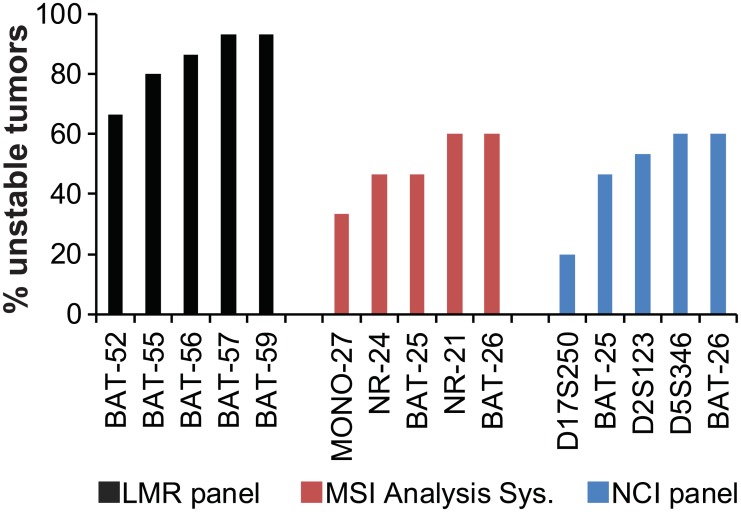
The relative MSI sensitivity of the LMR markers was significantly higher than that of currently used markers.A total of 15 tumors were classified as MSI-High using the LMR panel, the MSI Analysis System or the NCI panel. The percentage of tumors that were scored as MSI-positive is shown for each individual marker. The relative sensitivity of the LMR panel was significantly higher than that of the MSI Analysis System (p = 0.0012) and the NCI panel (p<0.0038) using the t-test.